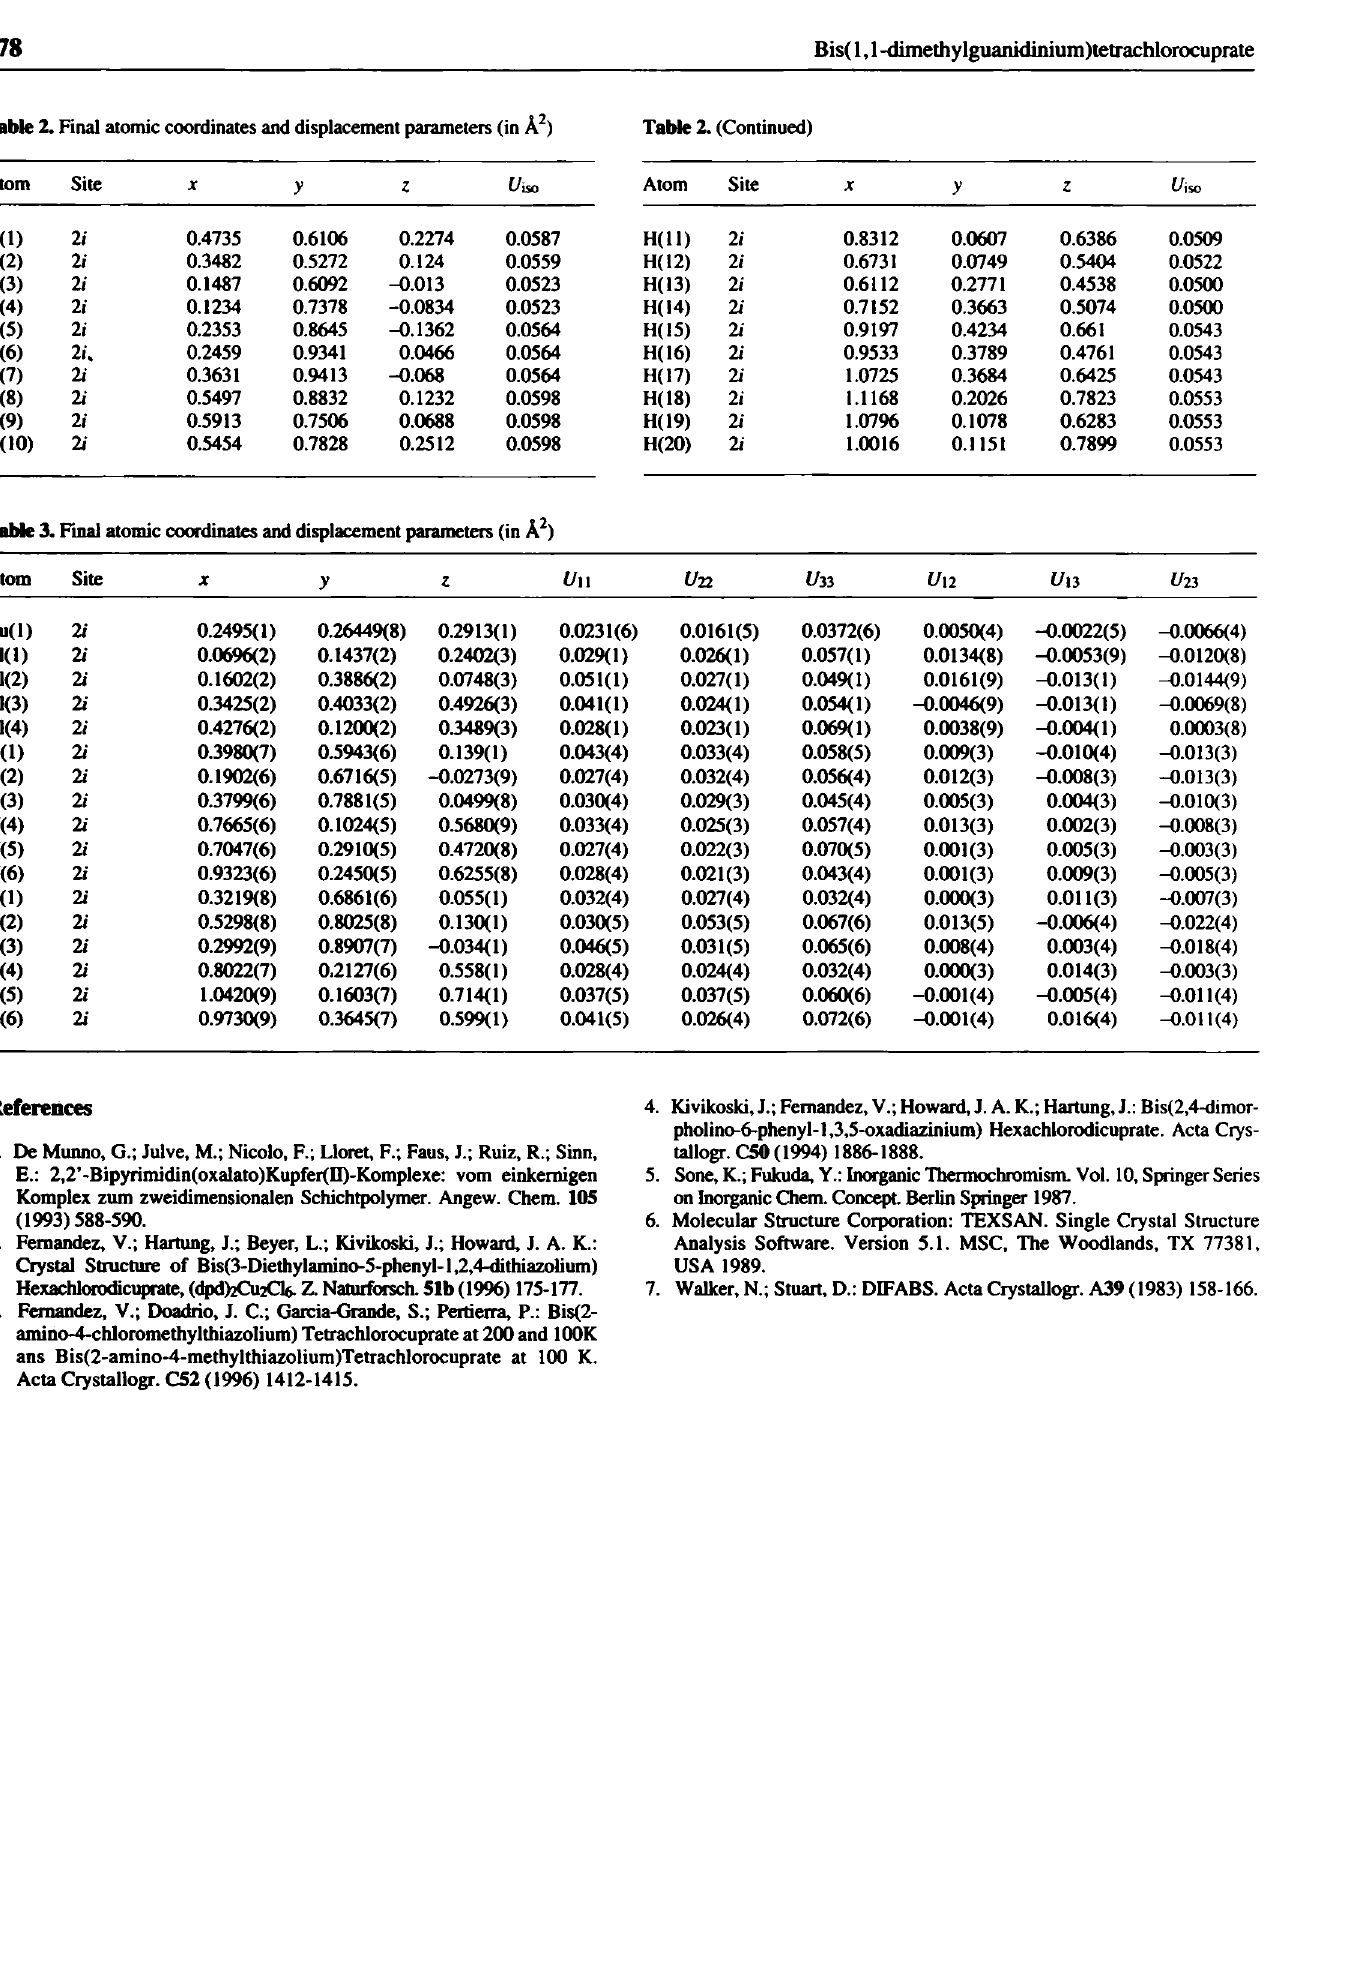
Table 2. Final atomic coordinates and displacement parameters (in À 2 ) Table 2. (Continued)